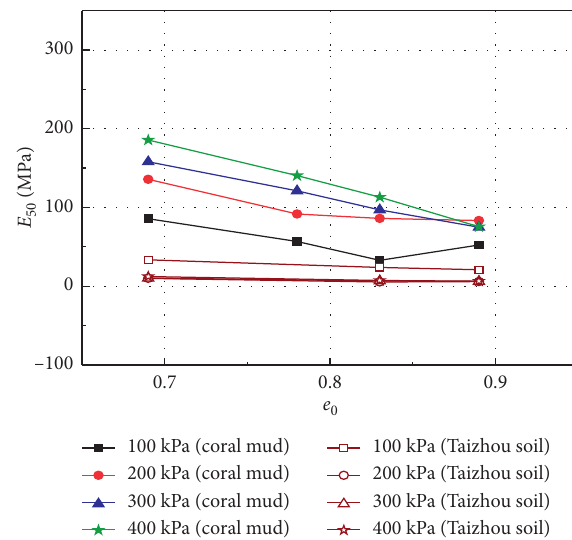
Figure 19: Relationship between E